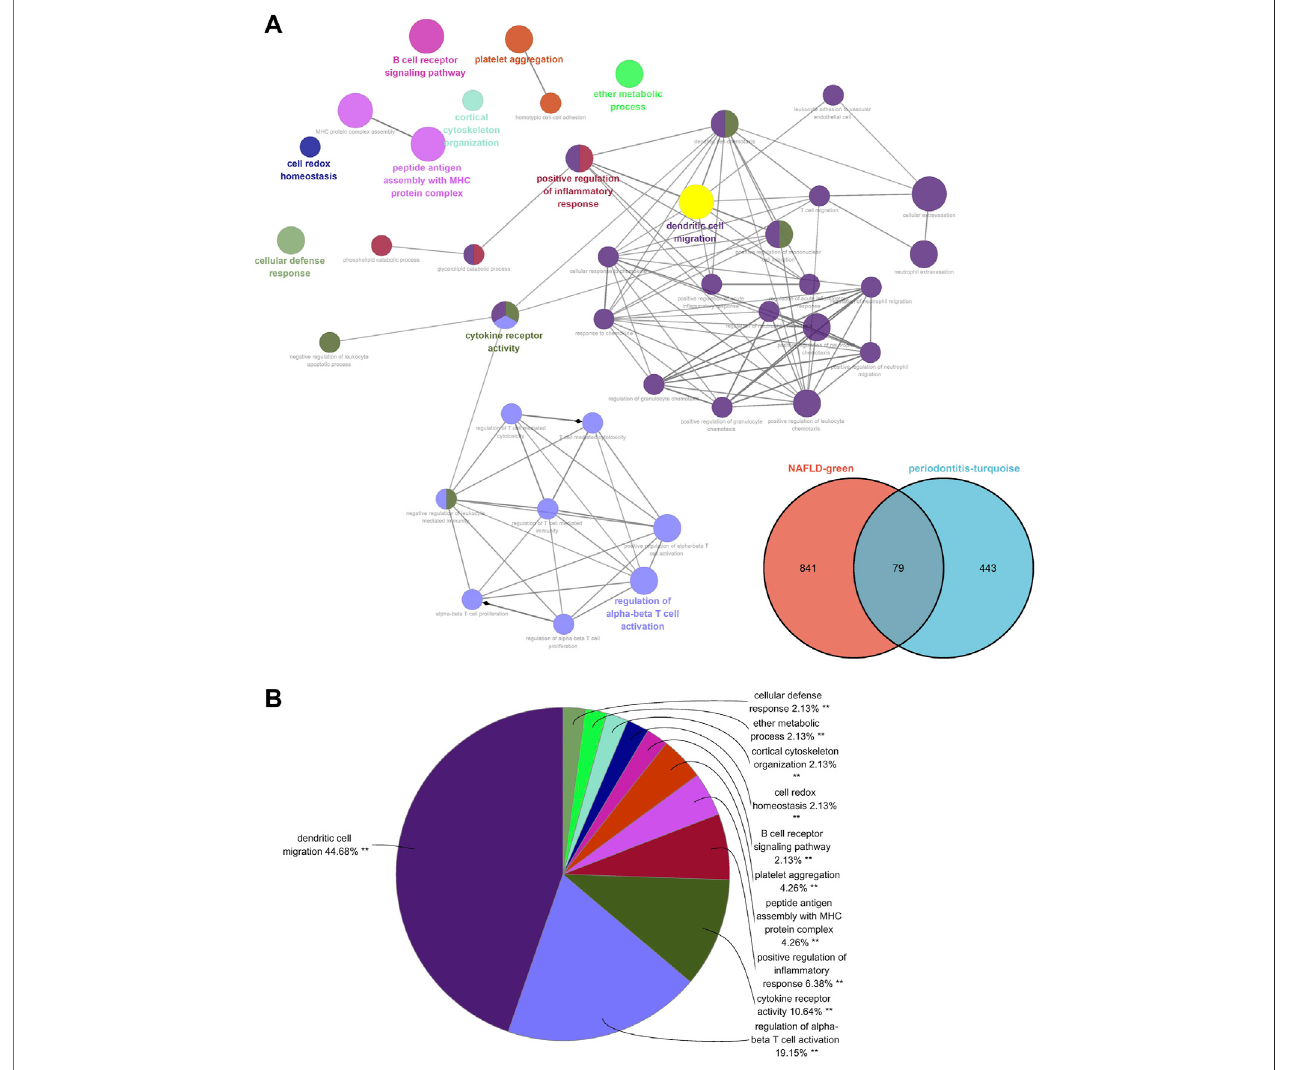
FIGURE 2 | ClueGO enrichment analysis. (A) The interaction network of GO terms generated by the Cytoscape plug-in ClueGO. (B) Proportion of each GO terms group in the total. GO, gene ontology. ** p < 0.05.